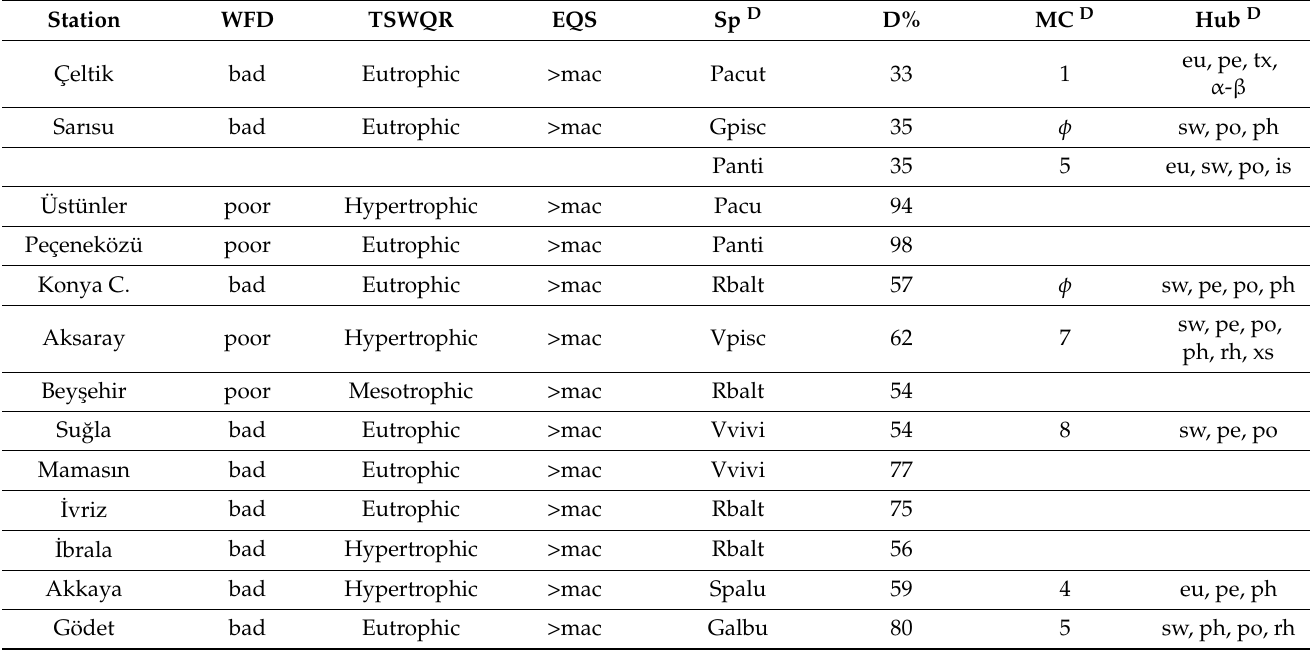
Table 6. Dominant species of each site, D%, tolerance level to pollution according to Mouthon and Charvet [42], and ecological data according to Hubenov